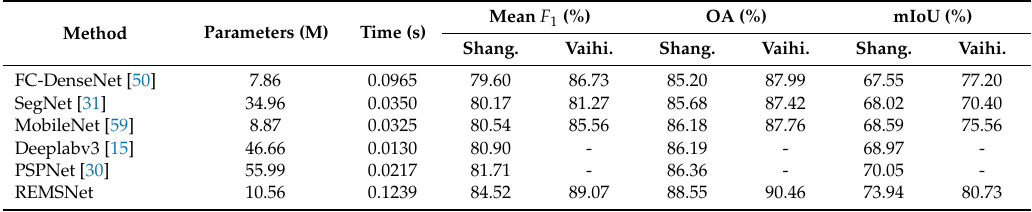
Table 4. Di ff erent model size and e ffi ciency analysis. “M” stands for million; “Shang.” Stands Shanghai dataset; “Vaihi.” Stands Vaihingen